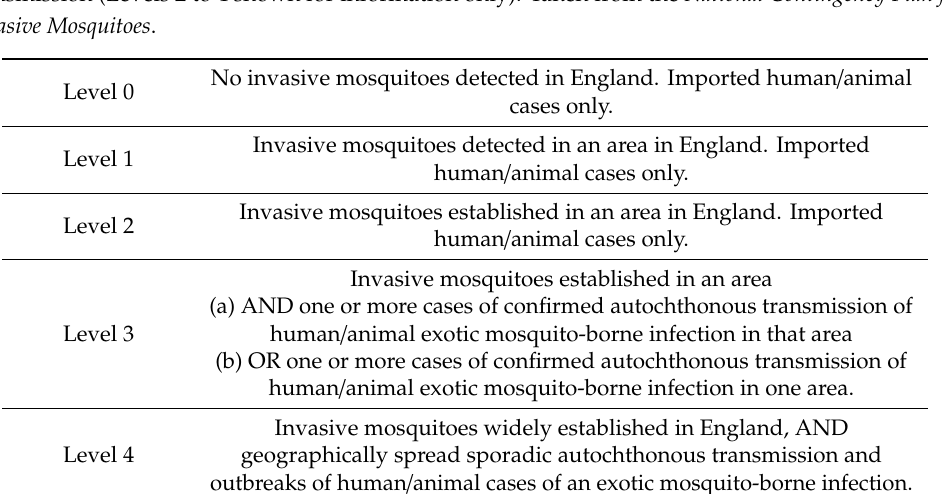
Level 3 human / animal exotic mosquito-borne infection in that area (b) OR one or more cases of confirmed autochthonous transmission of human / animal exotic mosquito-borne infection in one